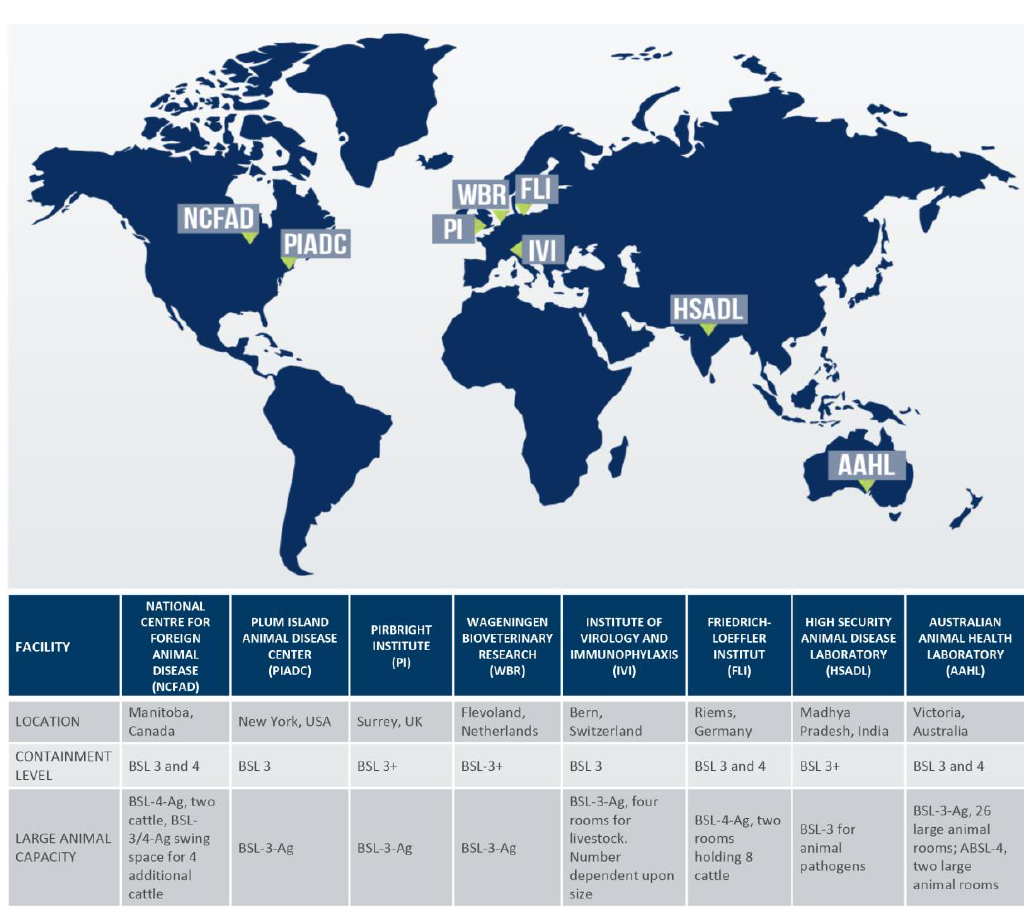
Figure 1. Worldwide map illustrating the locations of high-containment laboratories that can accommodate agricultural livestock. There are currently four BSL-3-Ag facilities, one BSL-3 for agricultural studies (HSADL), and three BSL-4 facilities [1]. The number of research animals that can be accommodated at one time is noted in the table when available.